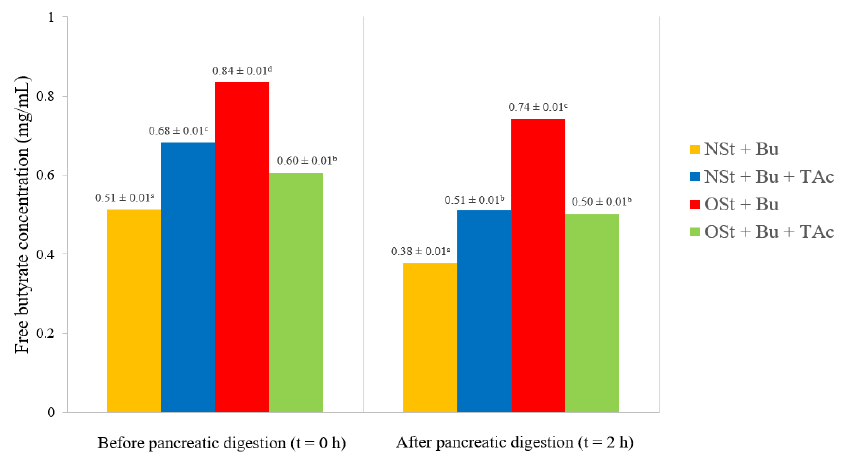
Figure 6. Free butyrate (Bu) content from the different butyrylated starch-based spaghetti-type pasta systems studied before and after pancreatic digestion. Different letters in the columns denotes statistically significant differences ( n = 3, p ≤ 0.05).